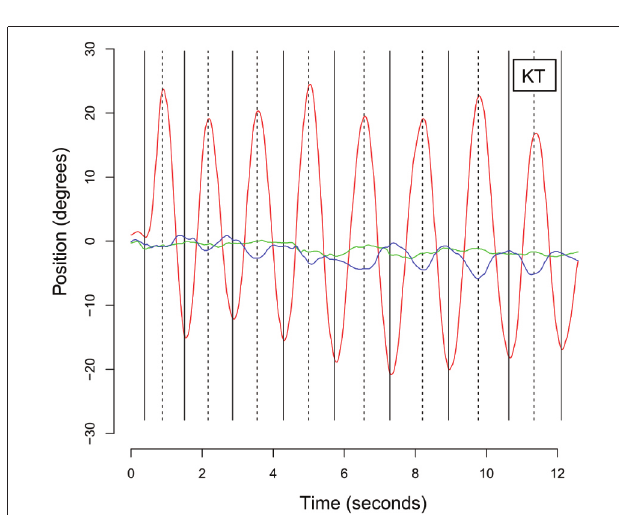
FIGURE 4 | Raw traces showing yaw (red), pitch (green) and roll (blue) position of the head measured as Euler angles in degrees over time (in seconds) during the first 12 s of a trial performed by a representative naive observer (KT). Note that the principal direction of head rotation is in yaw. Vertical solid and dashed lines indicate estimated troughs and peaks in the positional amplitude of yaw head rotation.